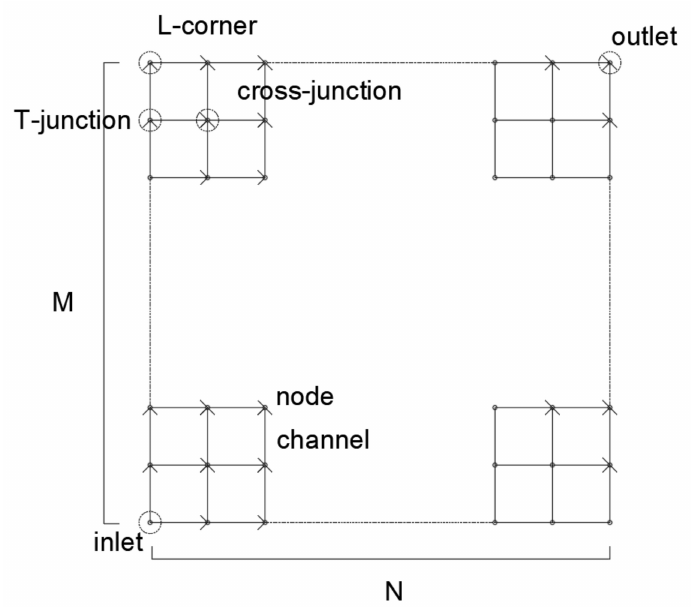
Figure 3. Channel network of pin-type flow field with flow direction and junction